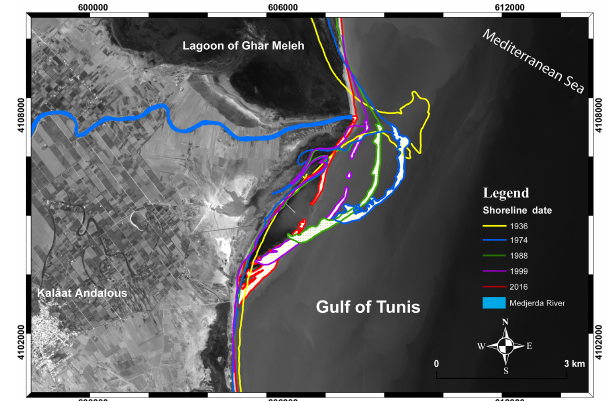
Figure 4. Multitemporal shoreline evolution of Kalaât Andalous.